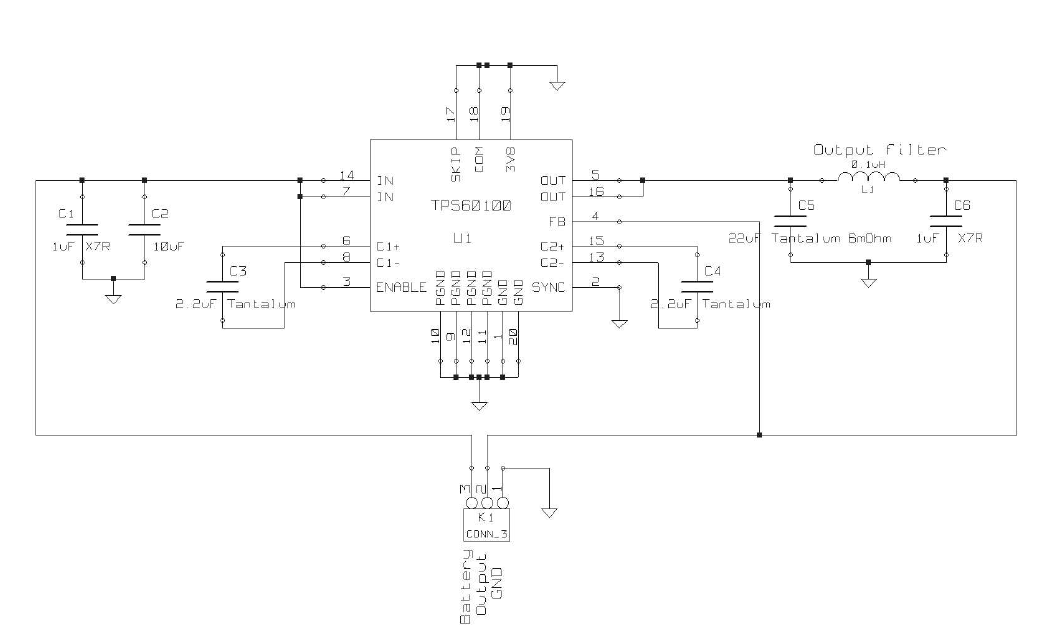
Figure 3. Schematic of the device power source. The core of this block is a step-up DC-DC converter